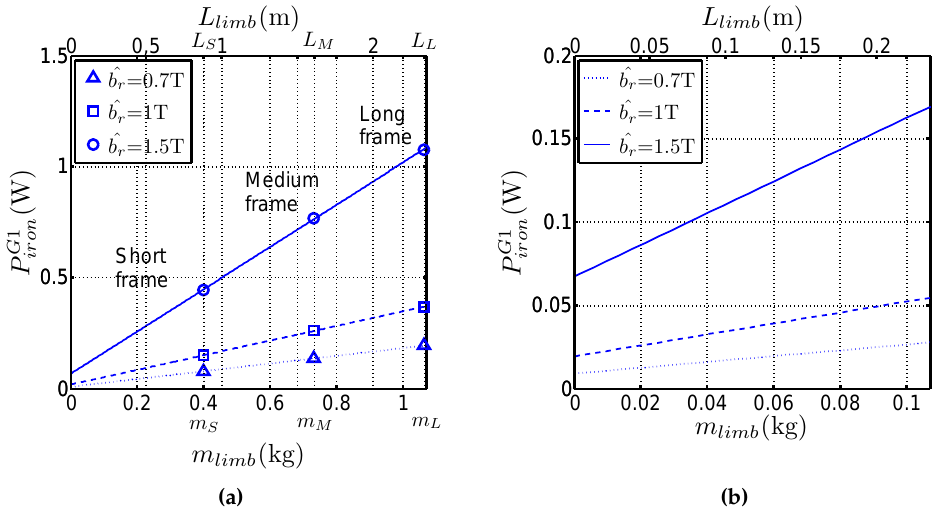
Figure 4. ( a ) Variations of P iron with m limb for ˆ b = 0.7T, ˆ b = 1T and ˆ b = 1.5T for G1 steel ( b ) Zoom near the abscissa 0.